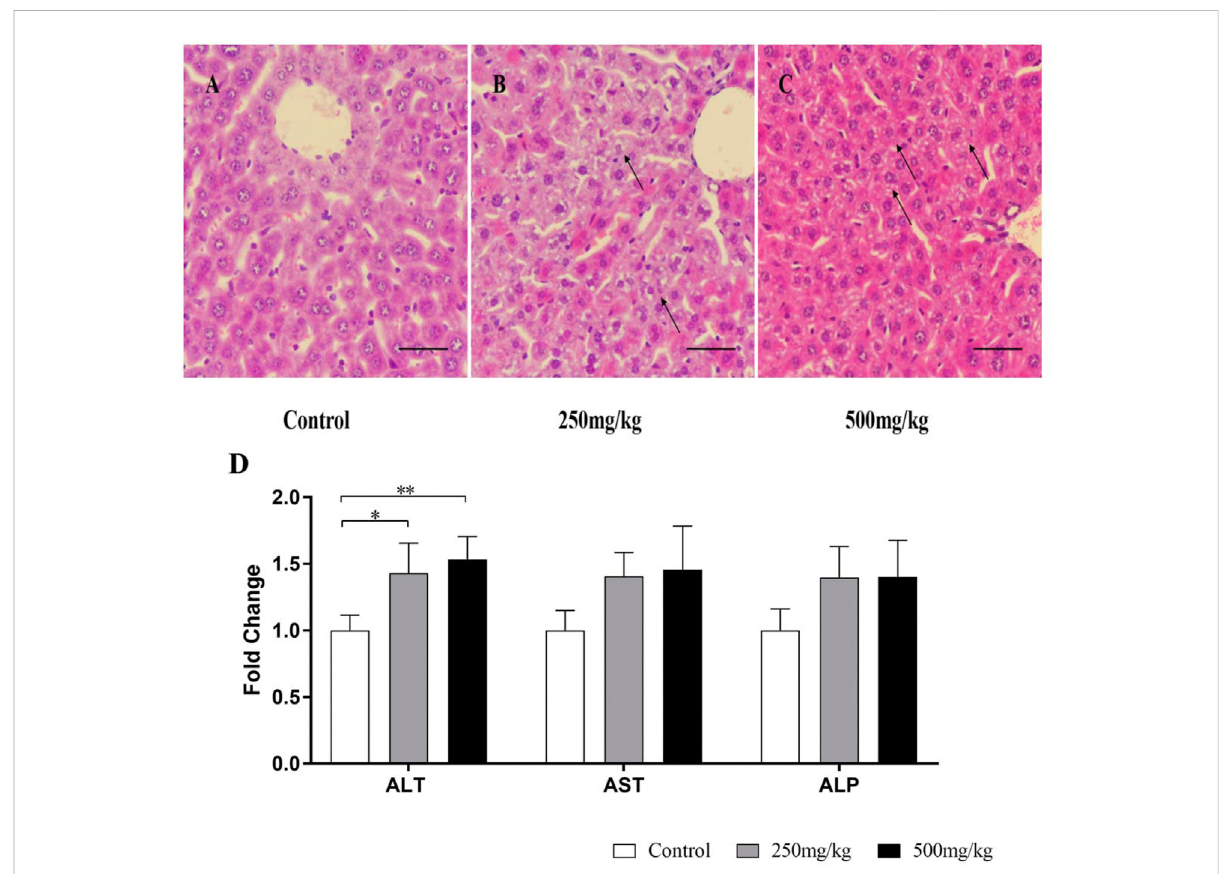
FIGURE 4 Liver injury in mice treated with VPA. Mice were treated with VPA at 250 or 500 mg/kg or the same volume of saline (5 ml/kg) once daily by intragastric administration for 28 days. (A – C) Hematoxylin and eosin staining of the liver sections. Representative images are shown (scale